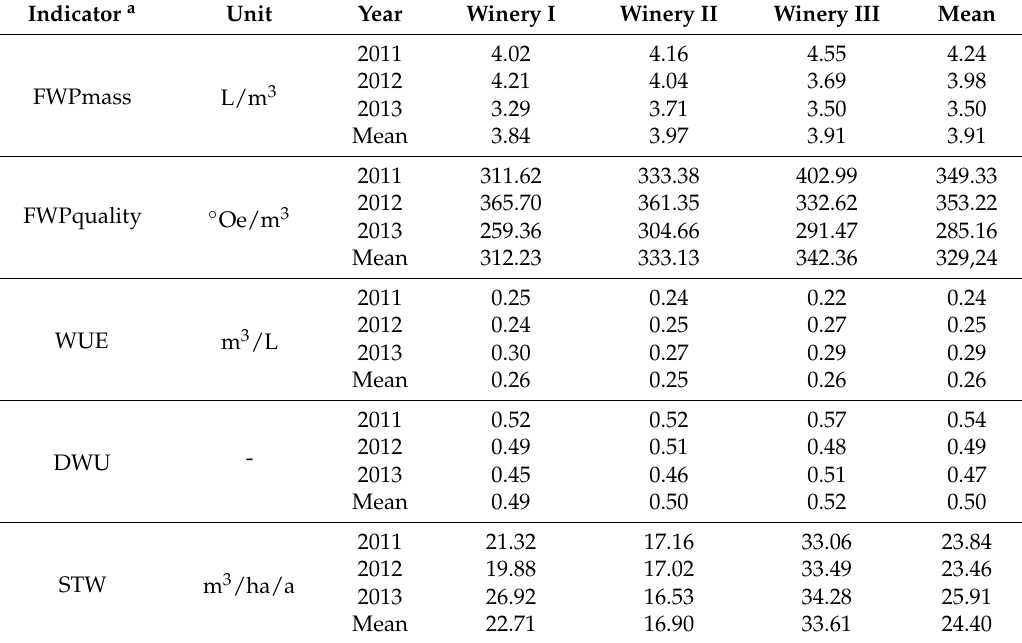
Table 8. Water-related indicators for Wineries I, II, and